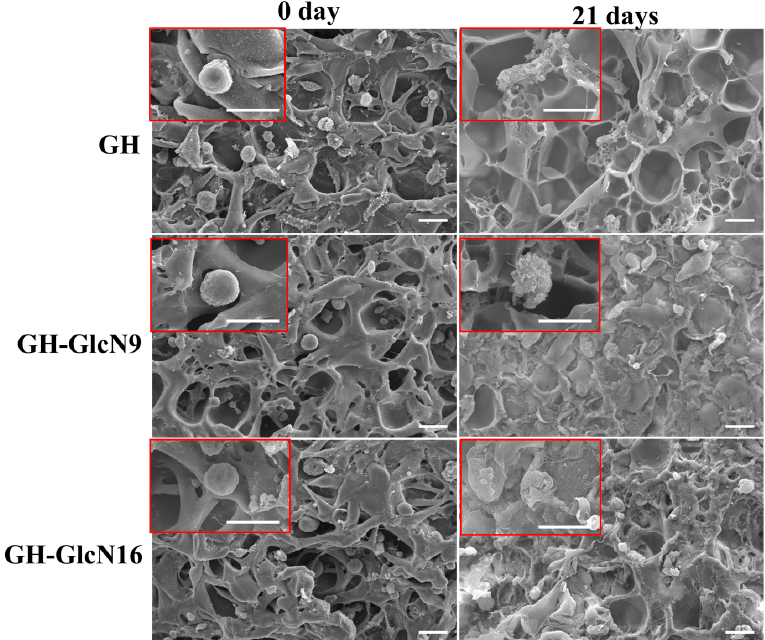
Figure 8. Scanning electron microscopy (SEM) observations of chondrocytes after culturing in GH, GH-GlcN9 and GH-GlcN16 cryogels for 0 and 21 days. The SEM images are shown at 500× and 2500× (inserts) magnifications. Bar = 20 μ m.